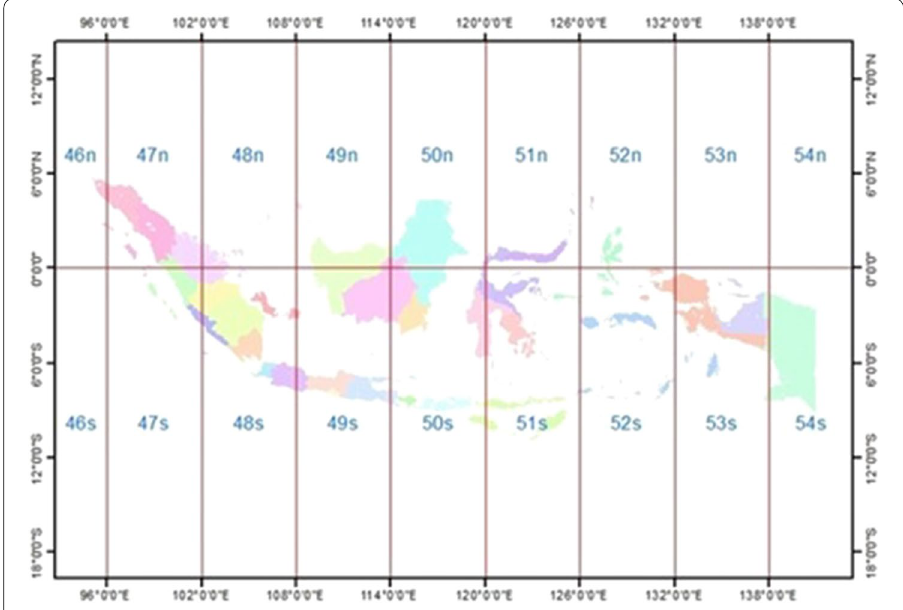
Fig. 7 Universal Transverse Mercator (UTM) Zone for Indonesia